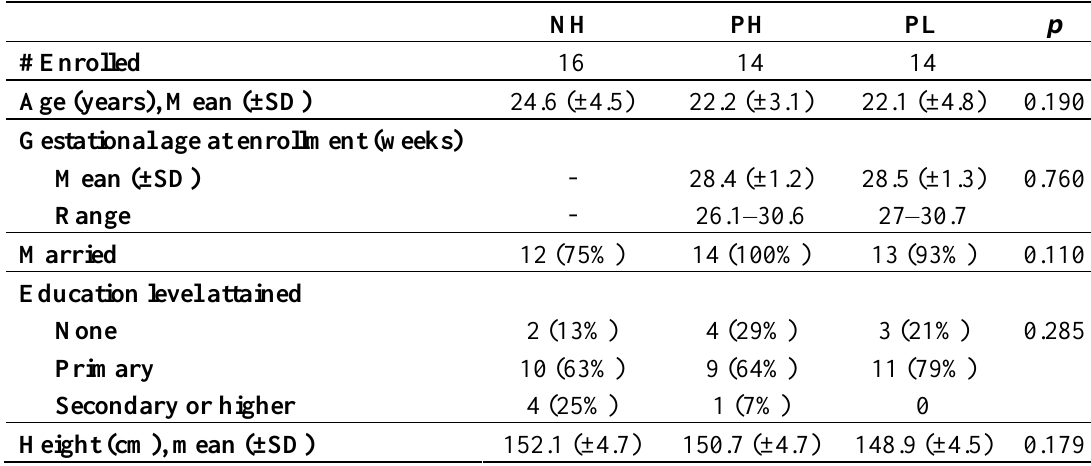
Table 1. Participant characteristics at enrollment.